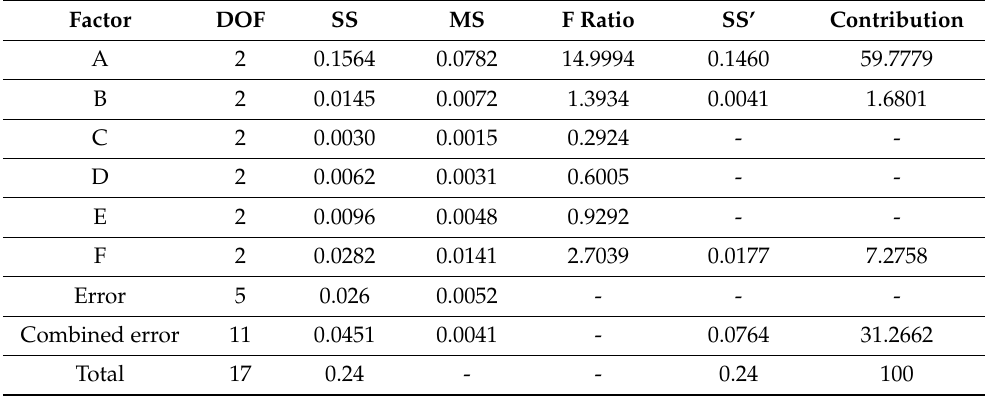
Table 17. The ANOVA of the far-infrared emissivity.